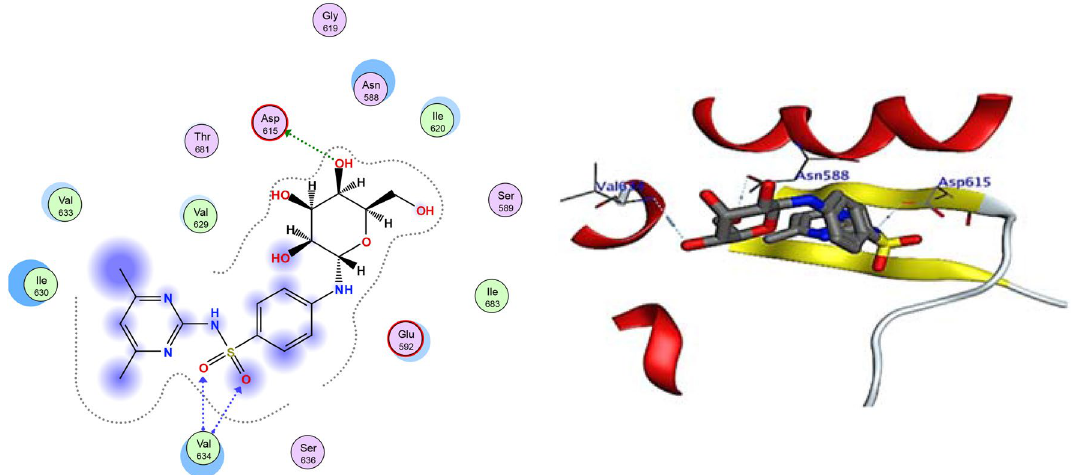
Figure 1. The 2D and 3D binding modes of 3a in the active site of DNA gyrase. H-bonds are represented by blue dashed